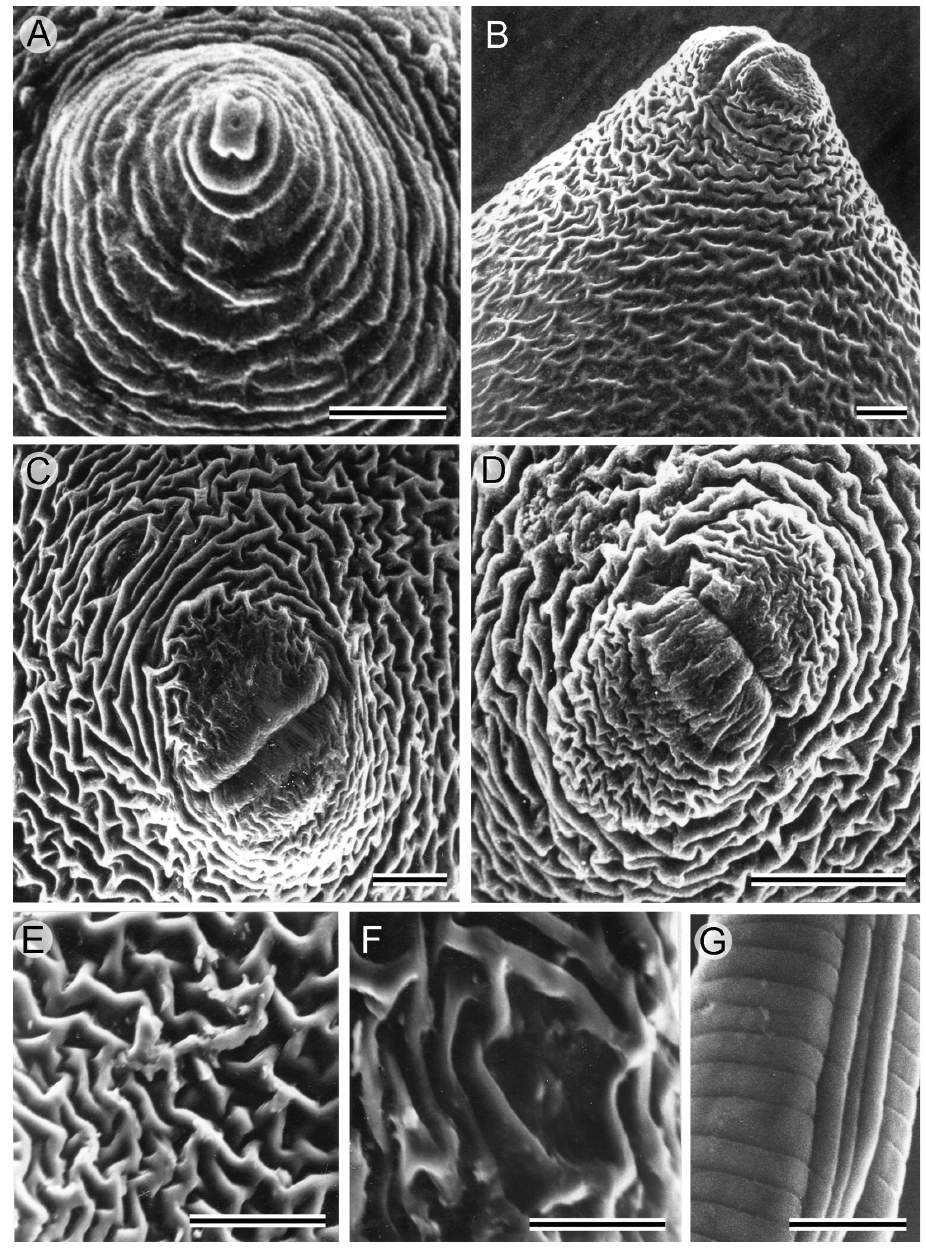
Figure 3. SEM photographs of the main cyst diagnostic characters of Heterodera fici from Italy. A Female anterior end B Lateral view of terminal cone C, D Fenestral area and anus E Maze-like cyst cuticular ornamentation F Cyst anal area G Male lateral fields. Scale bars: 10 μm ( A, G ); 20 μm ( B–F